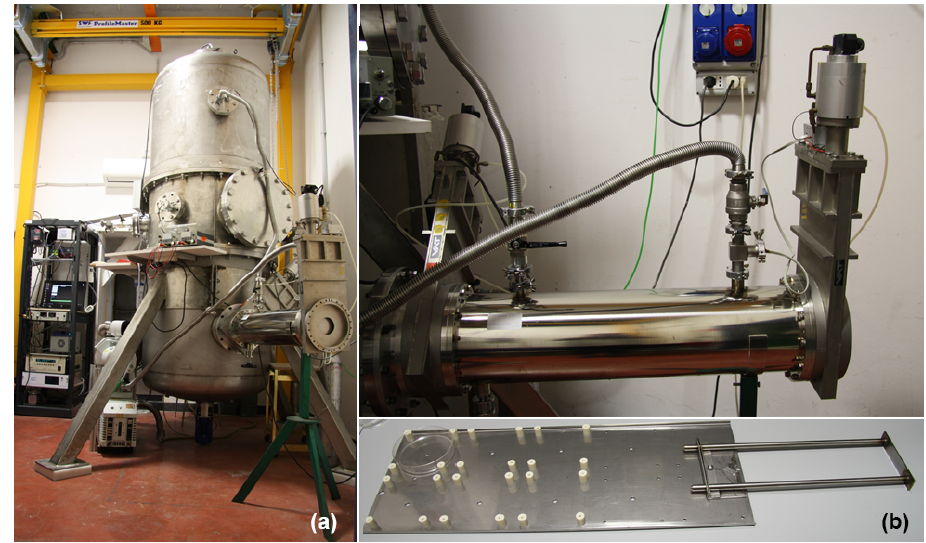
Figure 2. (a) The main structure of ChAMBRe: (b) the cylindrical volume (top), which hosts the sliding tray (bottom), used to introduce up to six Petri dishes (or other objects) inside the main ChAMBRe